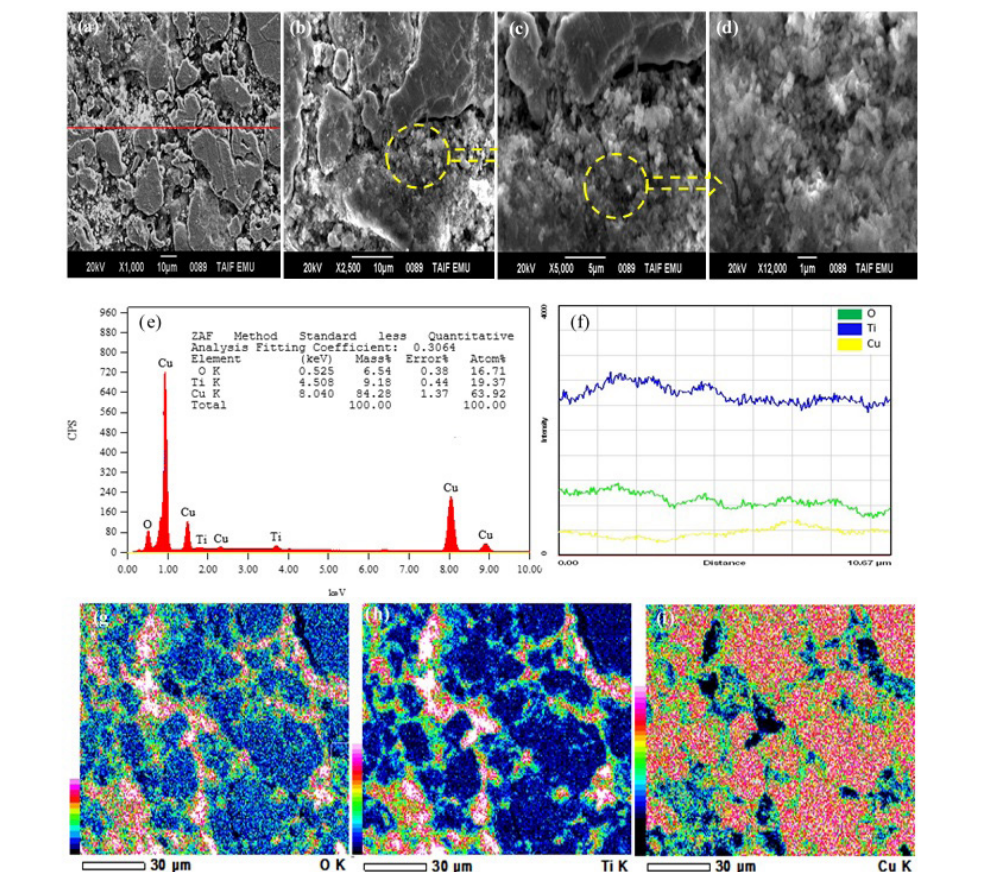
Figure 7. (a) The SEM micrographas images of 12 wt.% TiO2 nanocomposite; (b), (c), (d) Detailed regions of (a), with higher magnifications; EDS spectrum analysis of (a); (f) EDS Line analysis in (a); and (g), (h), (i) EDS mappings of Cu, Ti, and O elements present in